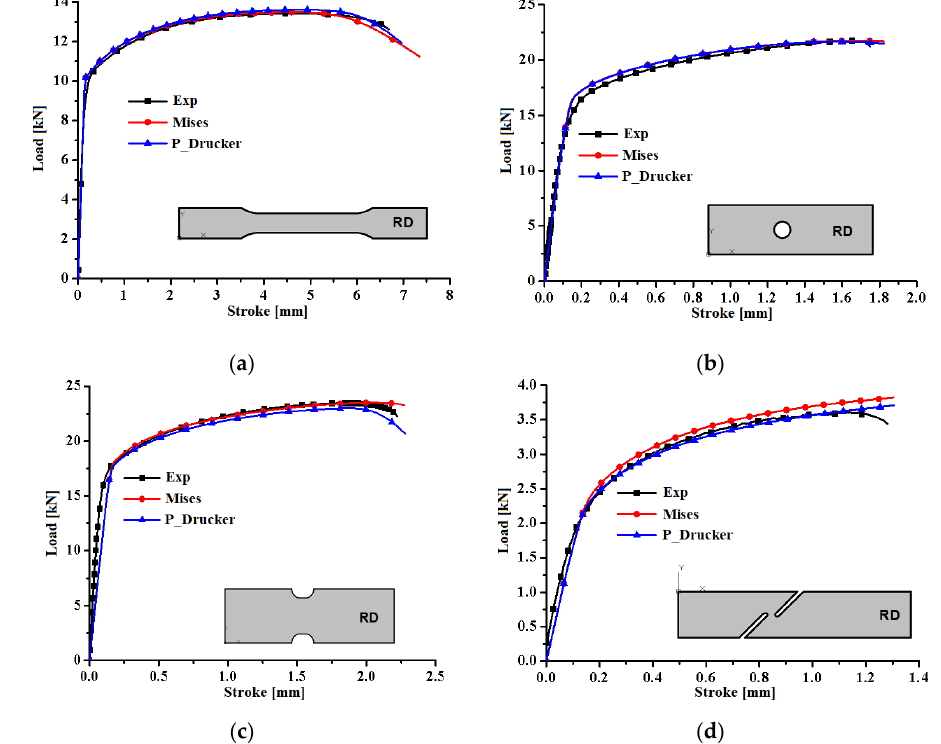
Figure 7. The comparison of the load-stroke curves between the experiment and simulation obtained from different yield functions along RD: ( a ) the dog-bone specimen; ( b ) the specimen with a central hole; ( c ) the notched specimen; ( d ) the in-plane shear specimen.